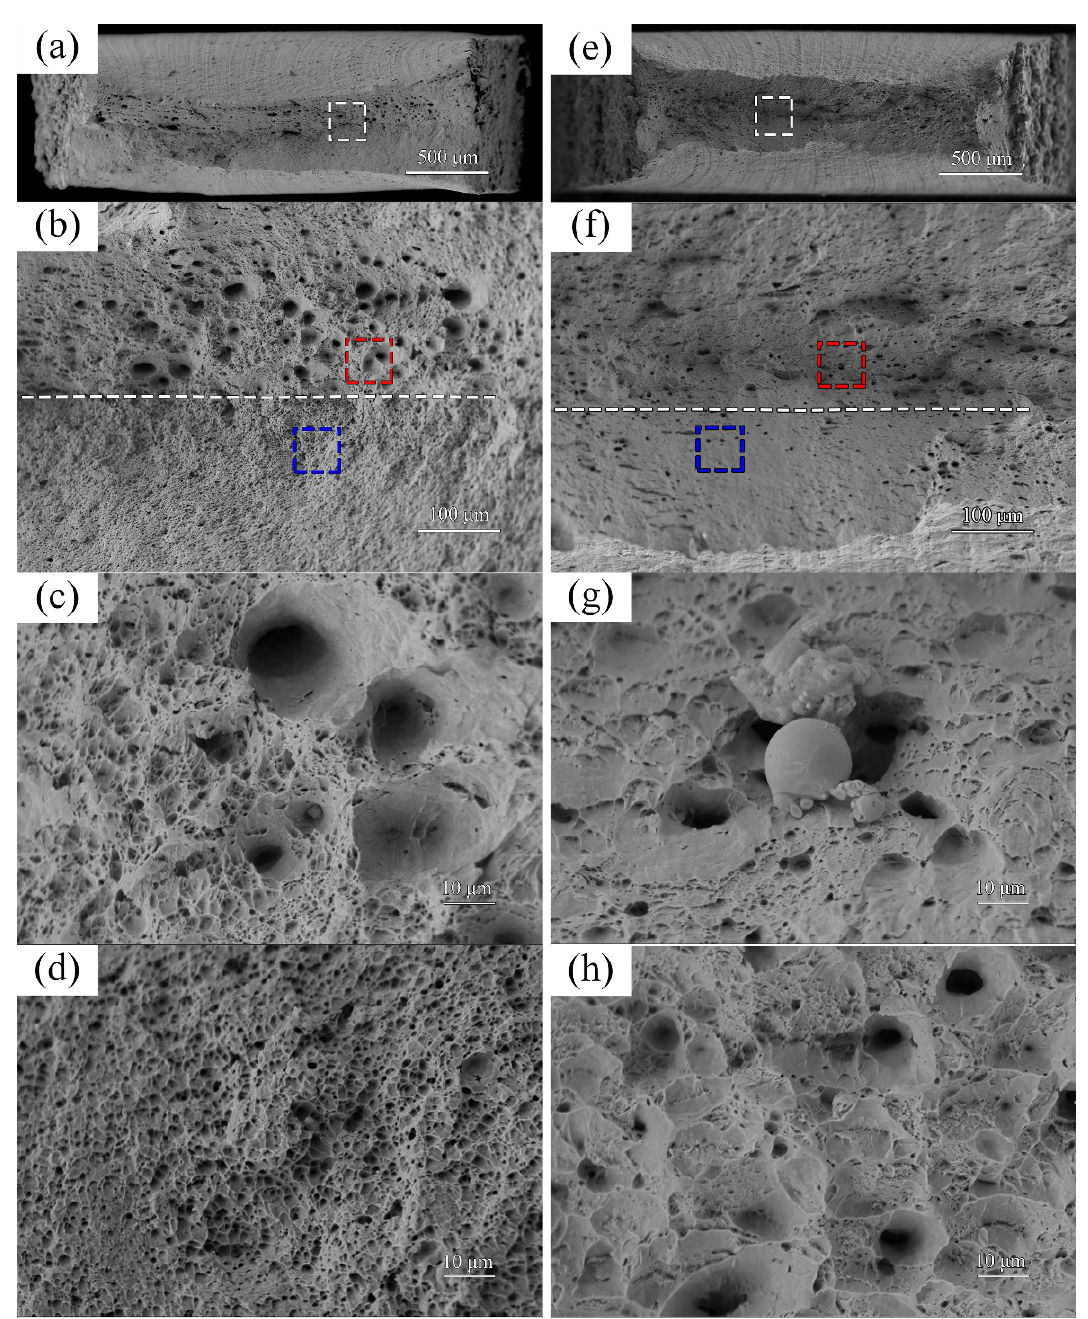
Figure 9. Fracture morphology with 10% reduction ratio: ( a ) macrostructure of sample 3; ( b ) microstructure of white square in Figure 9a; ( c ) microstructure of red square in Figure 9b; ( d ) microstructure of blue square in Figure 9b; ( e ) macrostructure of sample 5; ( f ) microstructure of white square in Figure 9e; ( g ) microstructure of red square in Figure 9f; and ( h ) microstructure of blue square in Figure 9f.